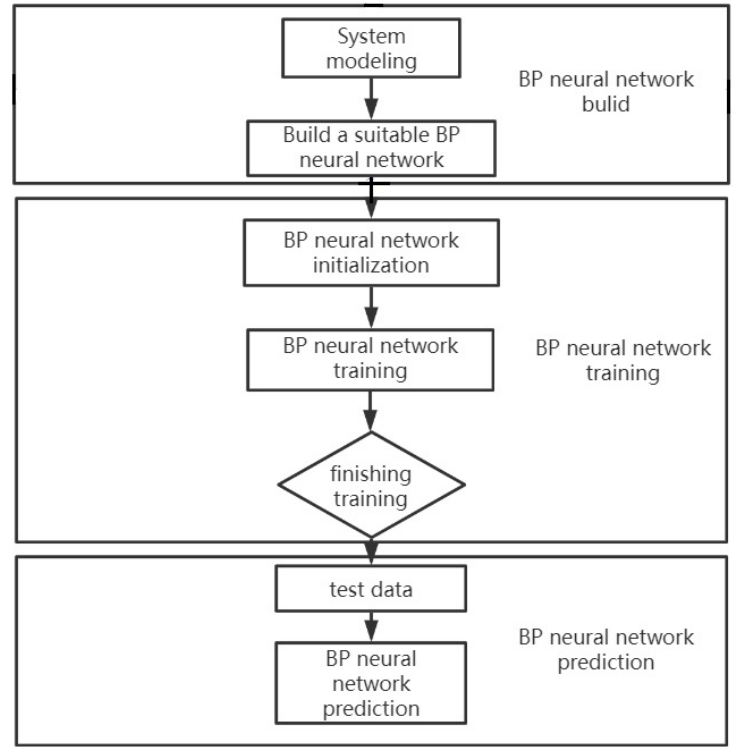
Figure 3. BP algorithm prediction